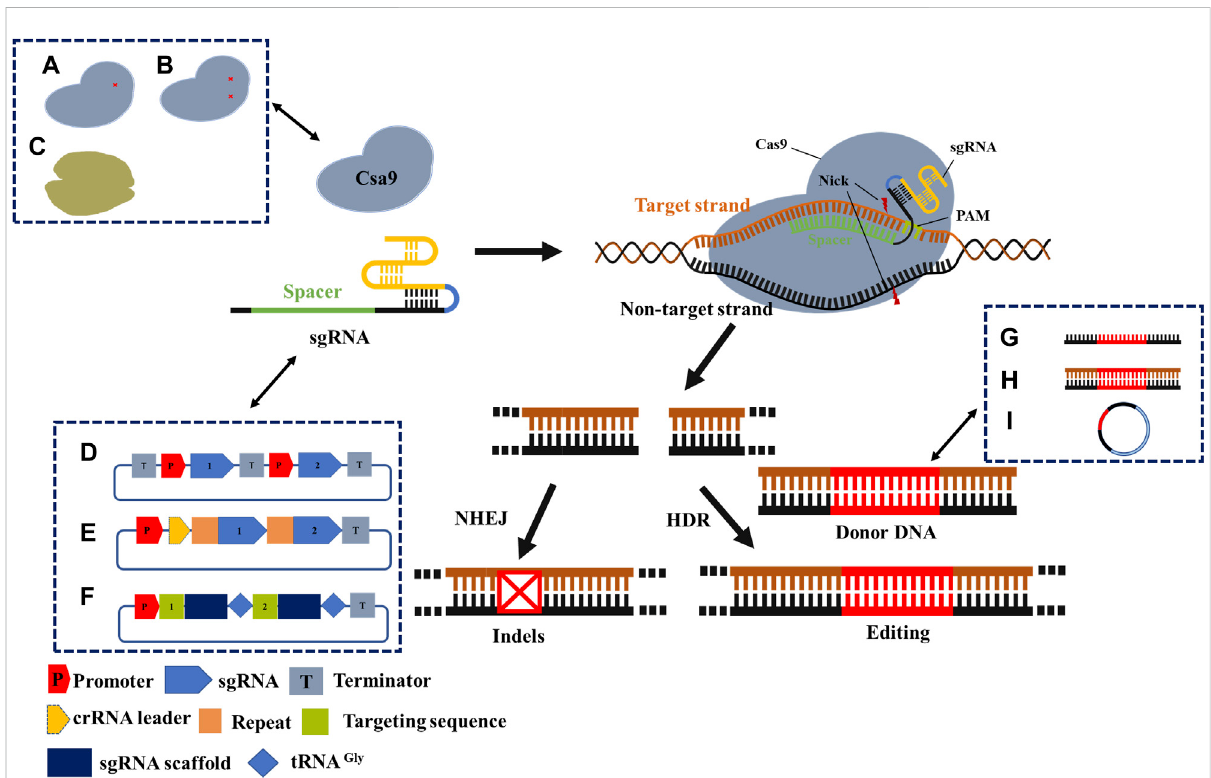
FIGURE 3 MechanismandoptimizationstrategyofCRISPR/Cas9gene-editingsystem. Cas9proteincleavesdouble-strandedDNAundertheguidanceof sgRNA to obtain DSB. Precise editing by the introduction of donor DNA in cells with HDR machinery, or formation of indels in cells with NHEJ repair machinery. A- C describes general optimization strategies. (A) Cas9 nickase; (B) Dead Cas9; (C) The other Cas proteins. (D) Independent expression of sgRNA; (E) Simultaneous expression of multiple sgRNAs; (F) tRNA process; (G) Donor DNA is provided as ssDNA; (H) Donor DNA is provided as dsDNA; (I) Donor DNA is provided as a plasmid. Recent applications of CRISPR/Cas